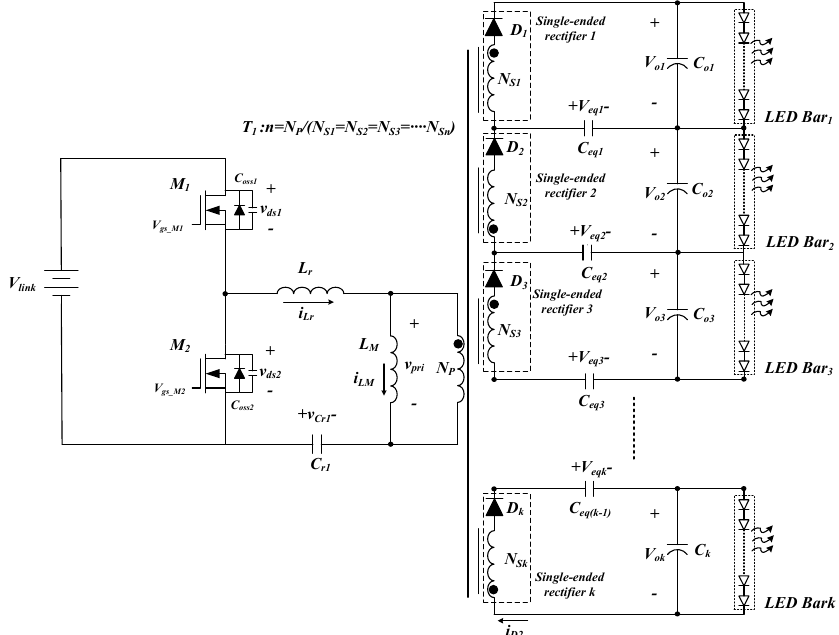
Figure 4. Extension of the proposed circuit for multichannel LEDs.